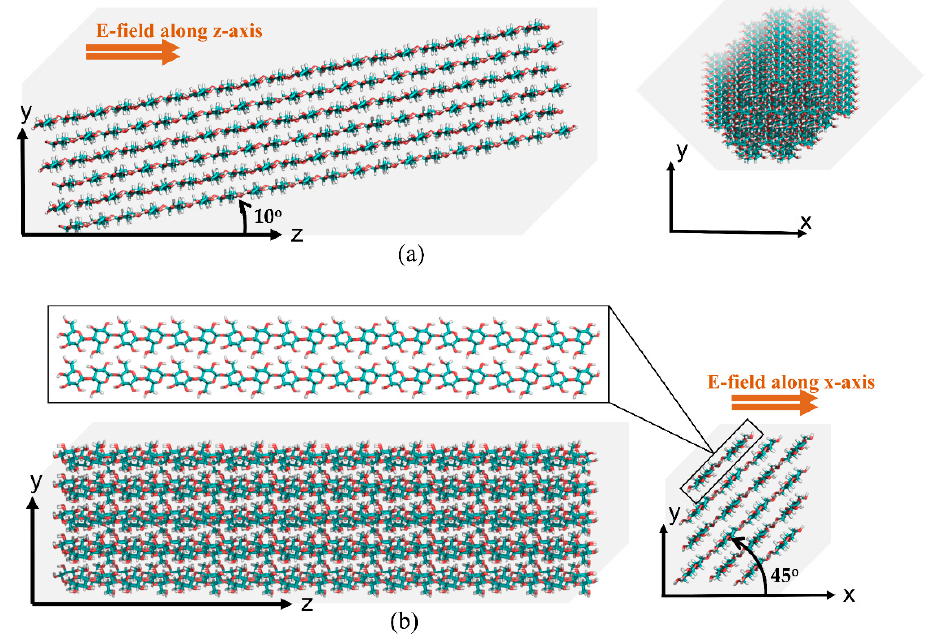
Figure 1. Electric field cases on the CNF model: ( a ) along the length direction (CASE 1) and ( b ) along the transverse direction (CASE 2).